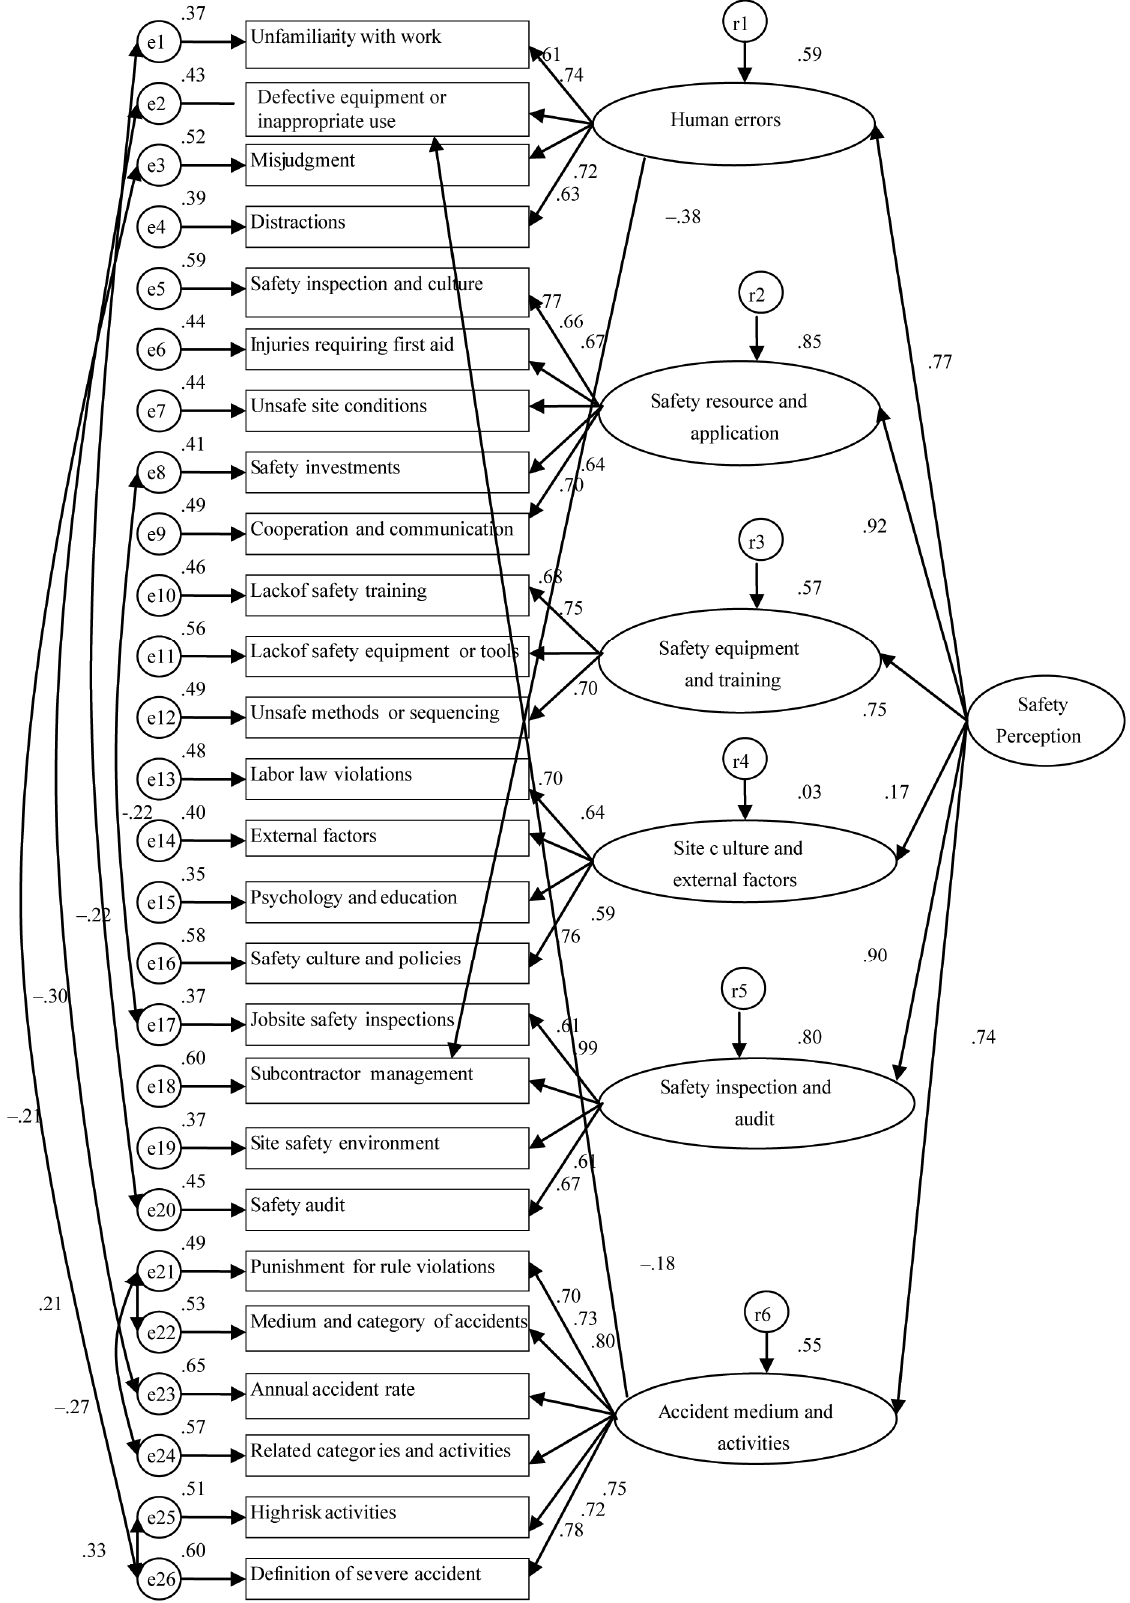
Fig. 3. Second-order fourth corrected (final)